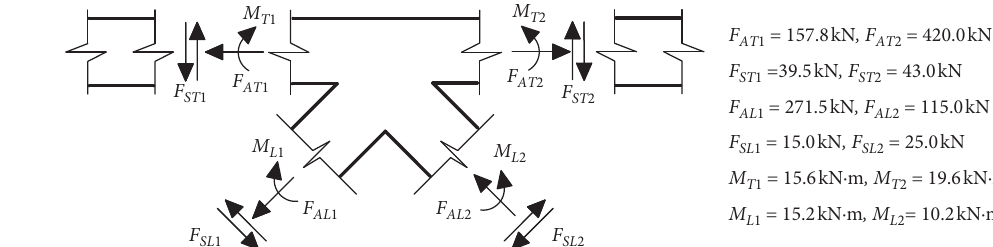
Figure 25: Force diagram of K-shaped connection.